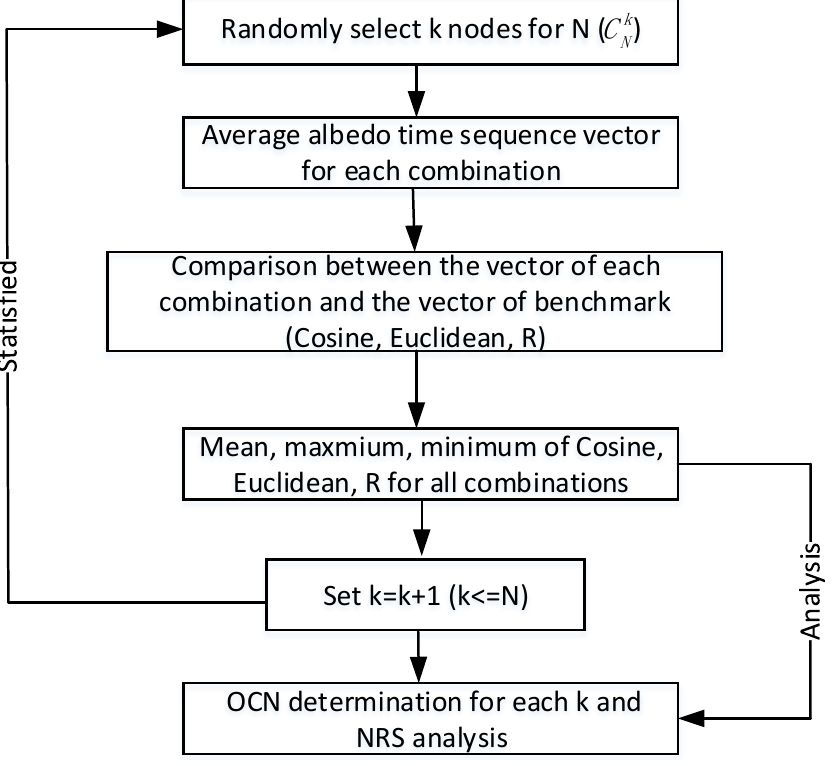
Figure 3. The flowchart of the random combination